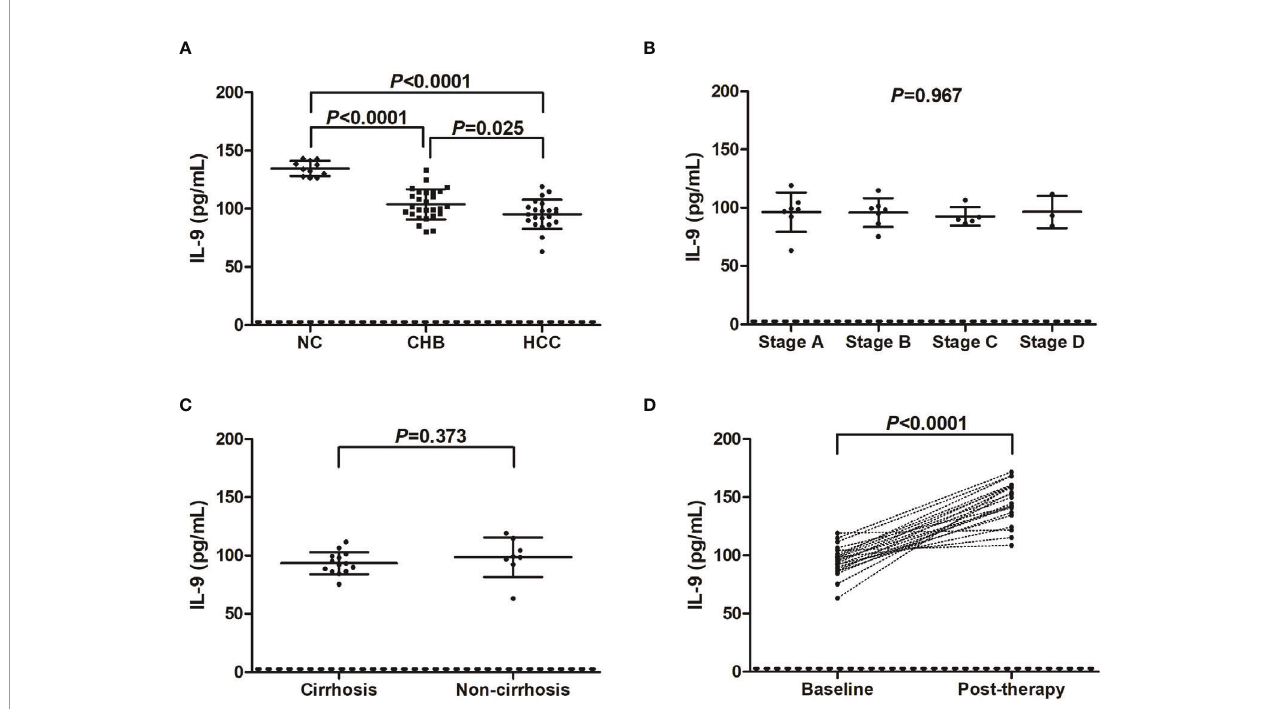
FIGURE 2 | IL-9 level in hepatitis B-related hepatocellular carcinoma (HCC). (A) Serum IL-9 concentration was measured by ELISA in normal controls (NC, n =11), chronic hepatitis B (CHB) patients ( n =27), and hepatitis B-related HCC patients ( n =22). Signi fi cance was assessed using one-way ANOVA and SNK- q test. (B) Serum IL-9 level was compared among hepatitis B-related HCC patients in BCLC stage A ( n =7), stage B ( n =7), stage C ( n =5), and stage D ( n =3). Signi fi cance was assessed using one-way ANOVA. (C) Serum IL-9 was also compared between hepatitis B-related HCC patients with cirrhosis ( n =14) and without cirrhosis ( n =8). Signi fi cance was assessed using Student t test. (D) Serum IL-9 was also measured in hepatitis B-related HCC patients who underwent hepatic carcinectomy (n=13) or TACE ( n =9), and was compared between baseline and 2 months post therapy. The dotted line presented lower detection limit for IL-9 (3.9 pg/mL). Signi fi cance was assessed using paired t